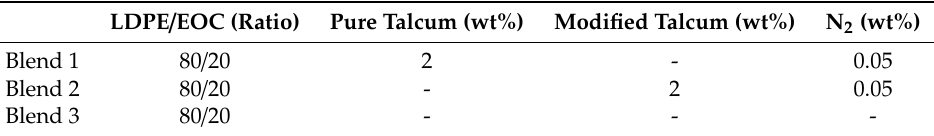
Table 2. Used material formulation for foaming